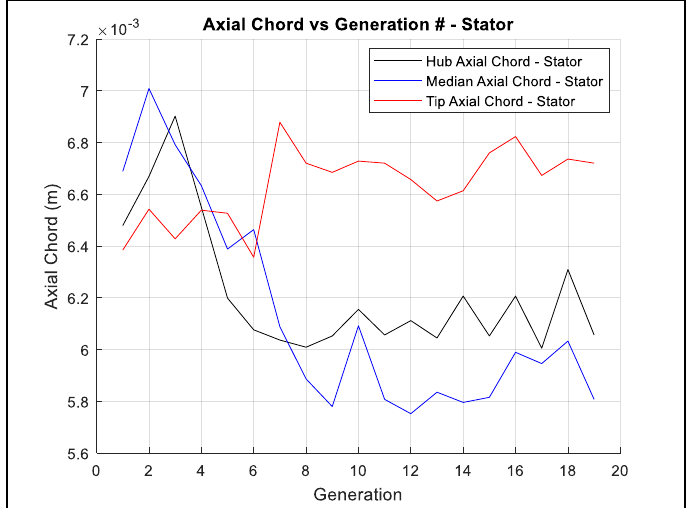
Figure 18. Elite member stator axial chord against generation number.